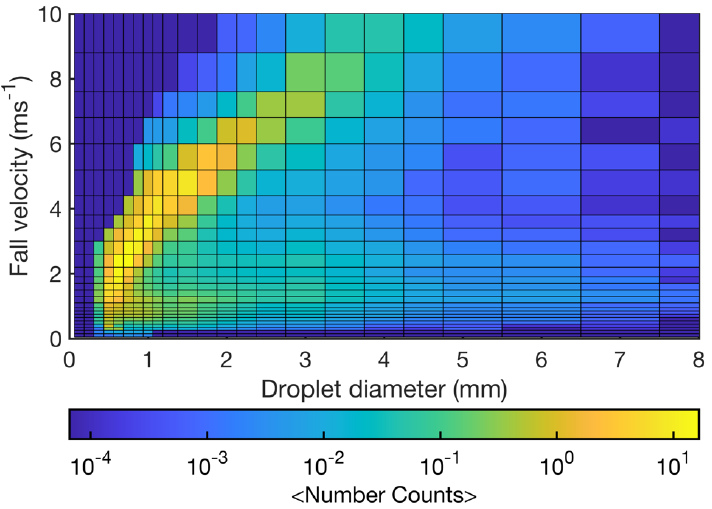
Figure 3. Mean hydrometeor number counts in droplet diameter and fall velocity classes for approximately 14,000 min with RR > 0 mmhr – 1 from an OTT Parsivel 2 disdrometer deployed at Cornell University (Table 1). Data from a few minutes with WC indicative of snow have been